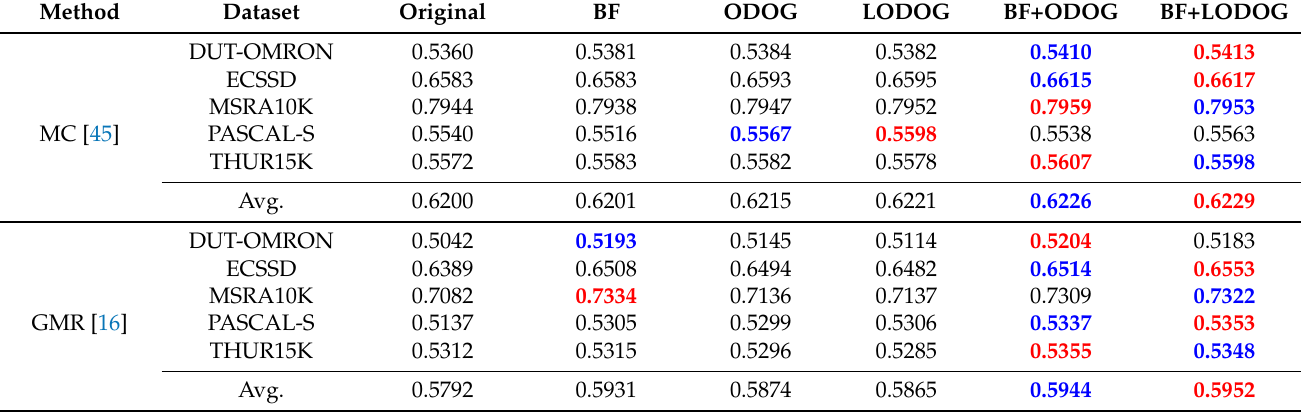
Table 4. F-measure comparison for each method used in the experiment. Red and blue indicate the best and second performances,